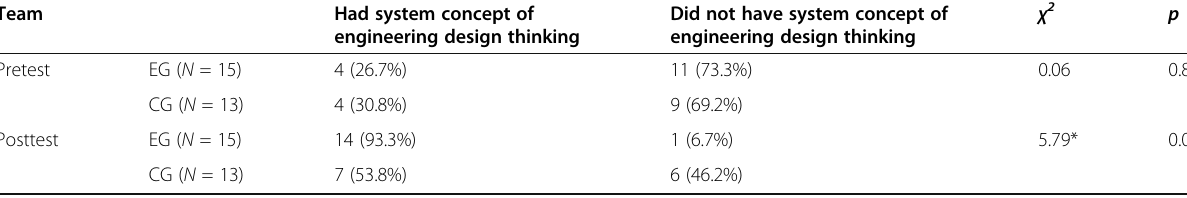
Table 3 Preservice technology teachers ’ performance: overall system concepts in engineering design thinking